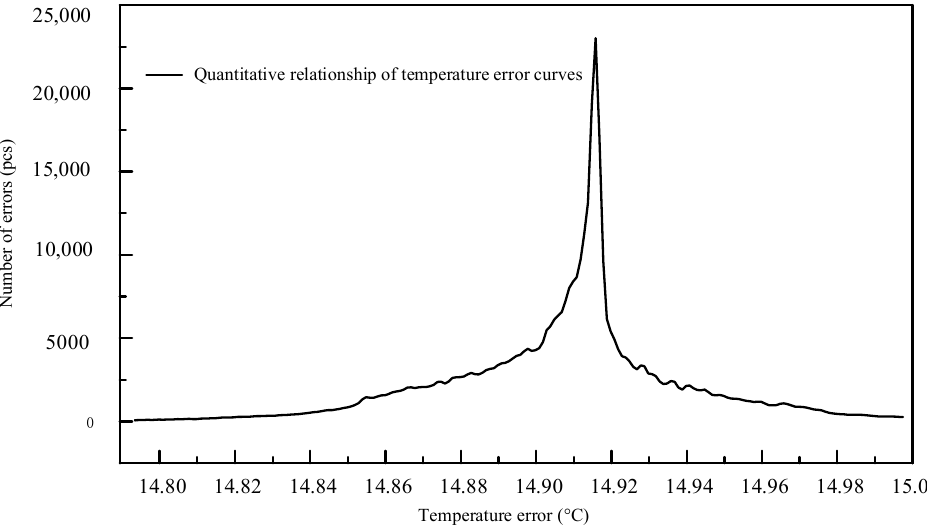
Figure 6. Raw temperature data and limit filtering. ( a ) initial temperature data; ( b ) temperature data after limiting filtering.